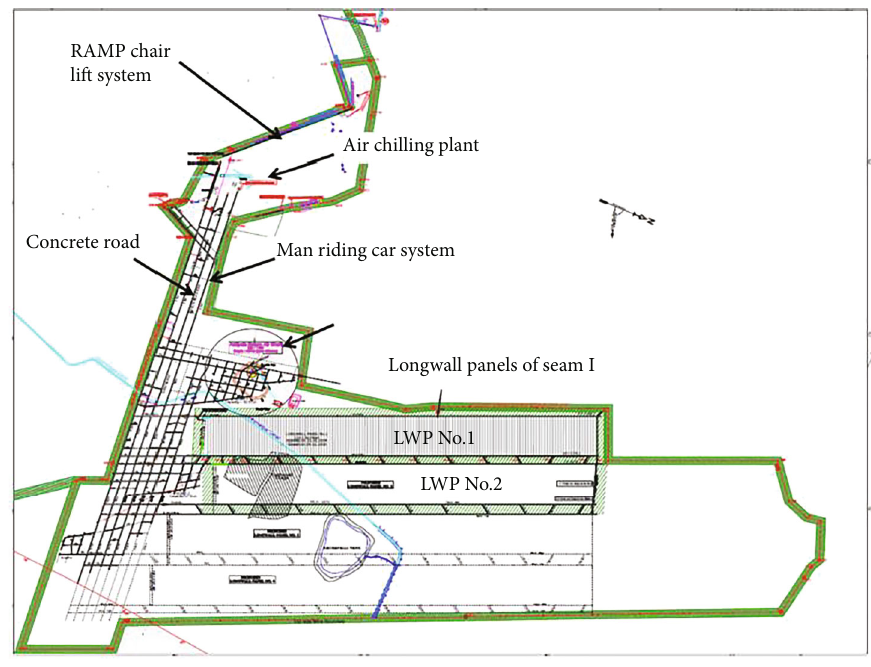
Figure 3: Key plan of